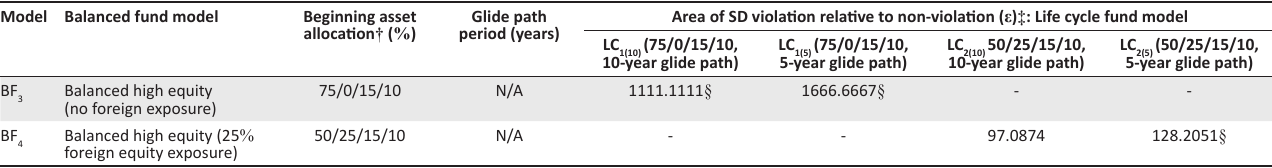
TABLE 3: ASD results of life cycle funds against balanced funds – similar starting asset allocation. Model Balanced fund